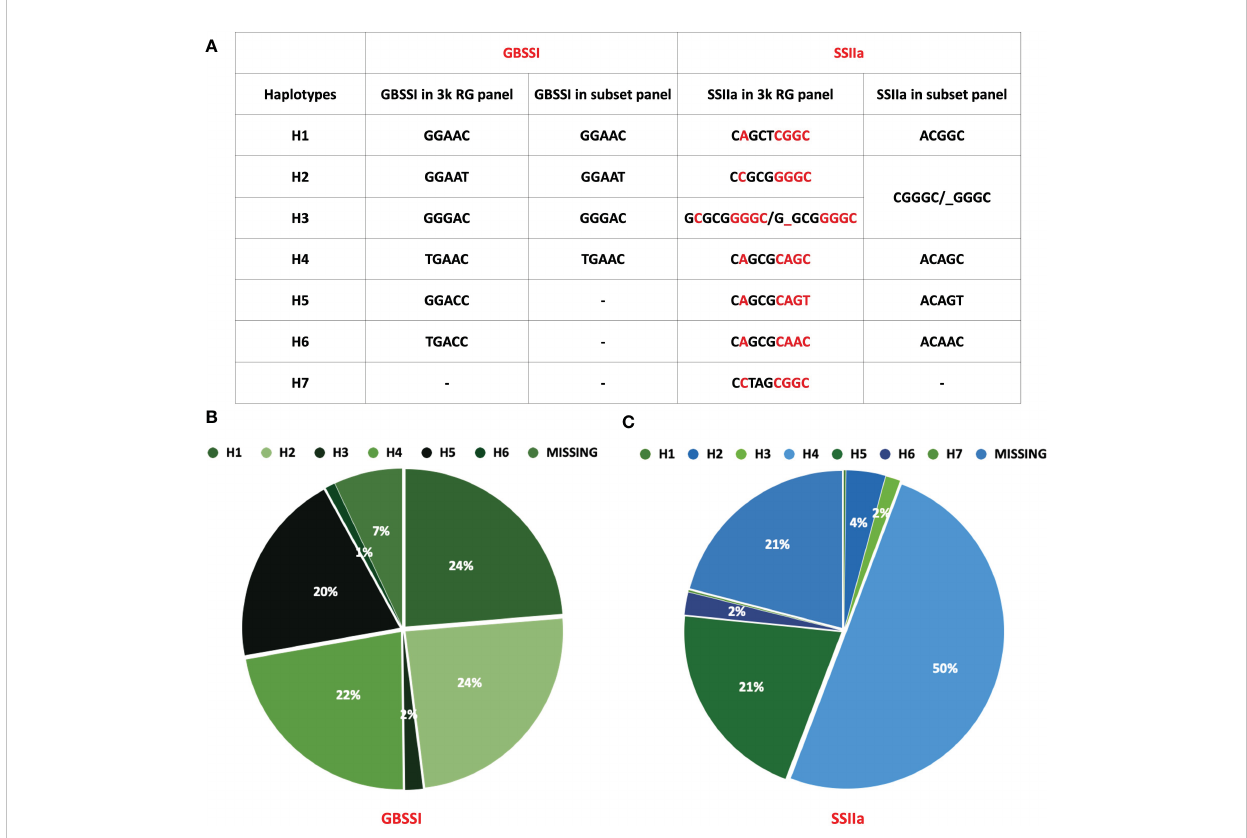
FIGURE 6 Distribution of haplotypes of GBSSI and SSIIa in rice 3k and its subset panel. (A) Table depicting the number of haplotypes in the 3k panel Vs. the subset panel for both genes, (B) Pie chart showing the % distribution of GBSSI haplotype in the 3k RG panel, (C) Pie chart highlighting the % distribution of haplotypes in SSIIa across 3k RG